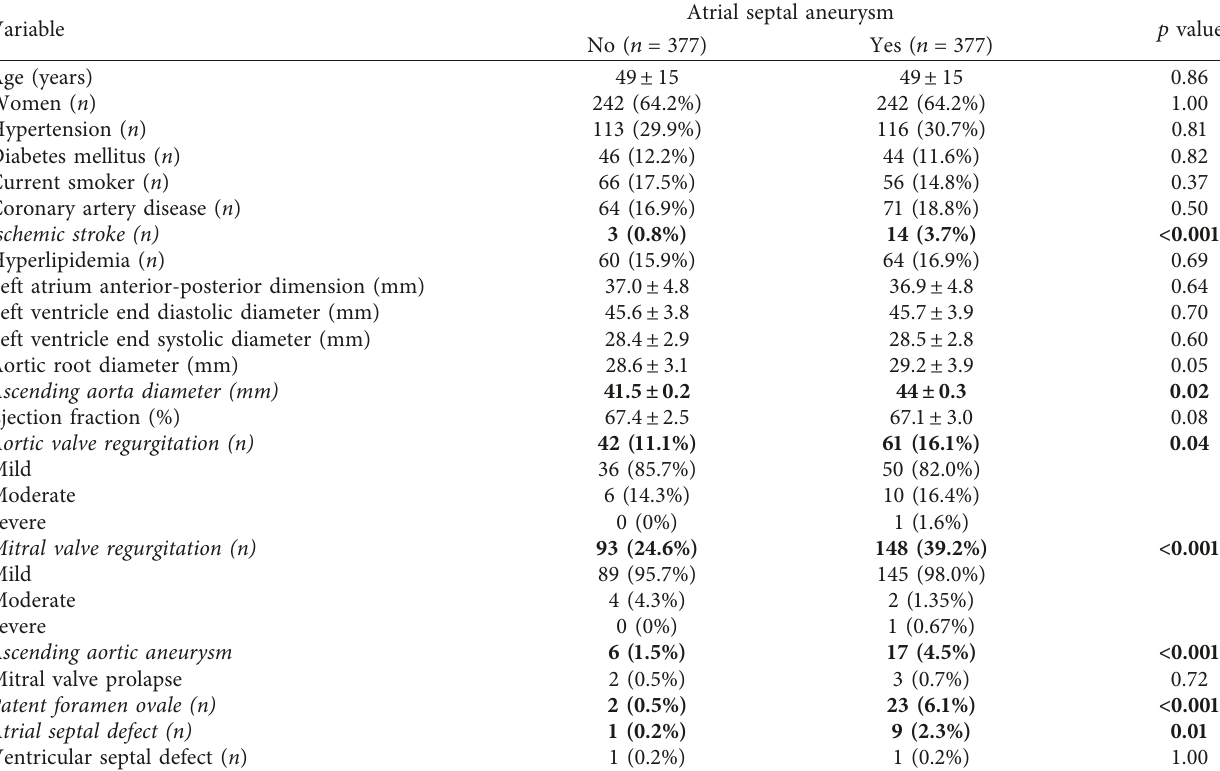
Table 1: Baseline demographics, echocardiographic parameters, and pathologies of the study population.